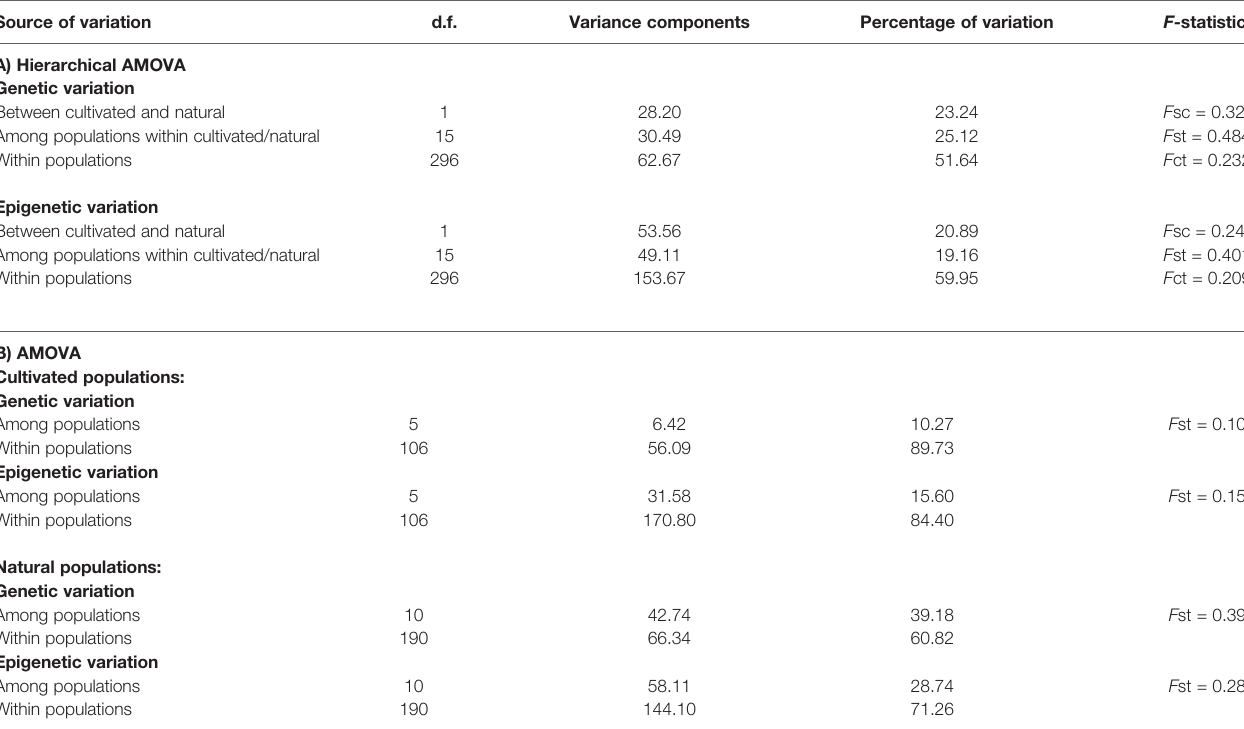
TABLE 2 | (A) Three-level hierarchical analysis of epigenetic and genetic molecular variation (AMOVA) for 17 populations of Corydalis yanhusuo (B) Genetic and epigenetic AMOVA for natural and cultivated populations analyzed separately. Source of variation